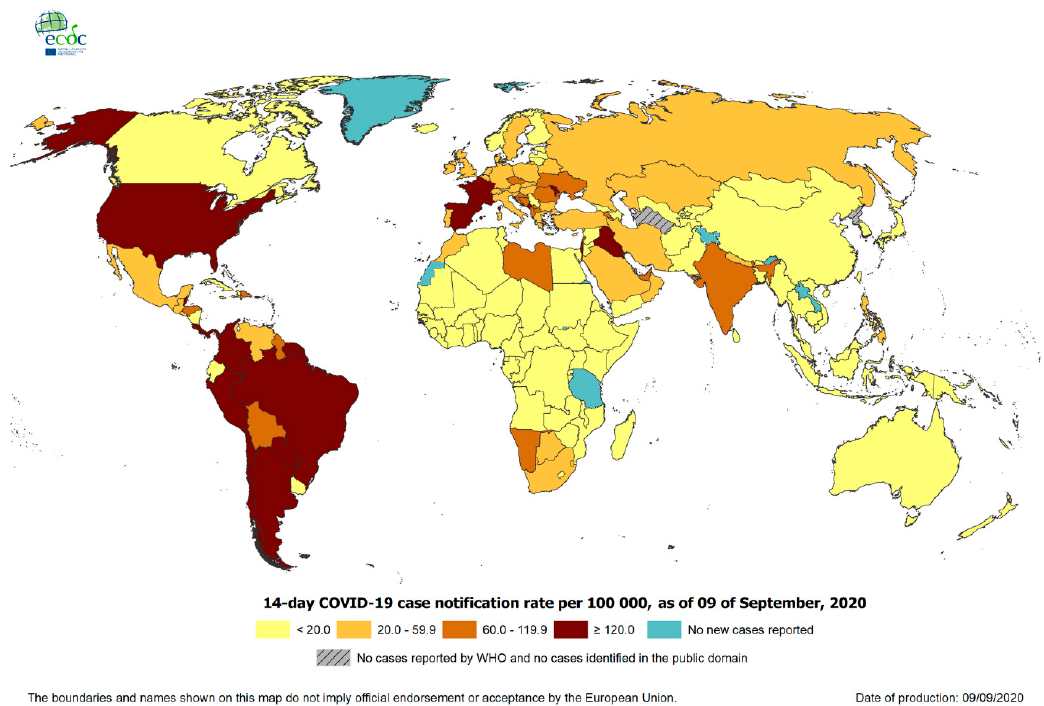
Figure 1. European Centre for Disease Prevention and Control report on the coronavirus (COVID-19) situation worldwide as of 9 September 2020 [8].